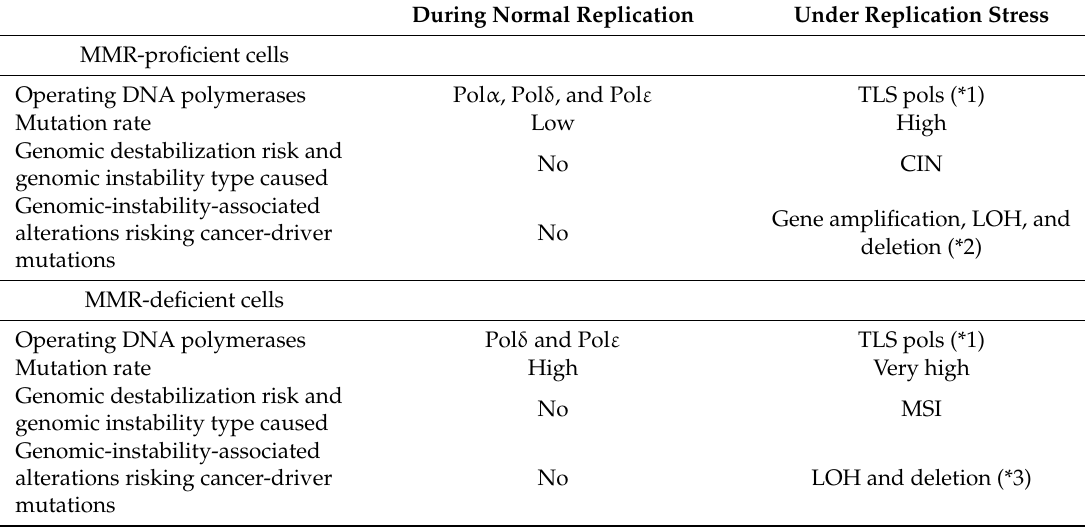
Table 1. Risks of mutation induction and genomic destabilization during normal replication and under replication